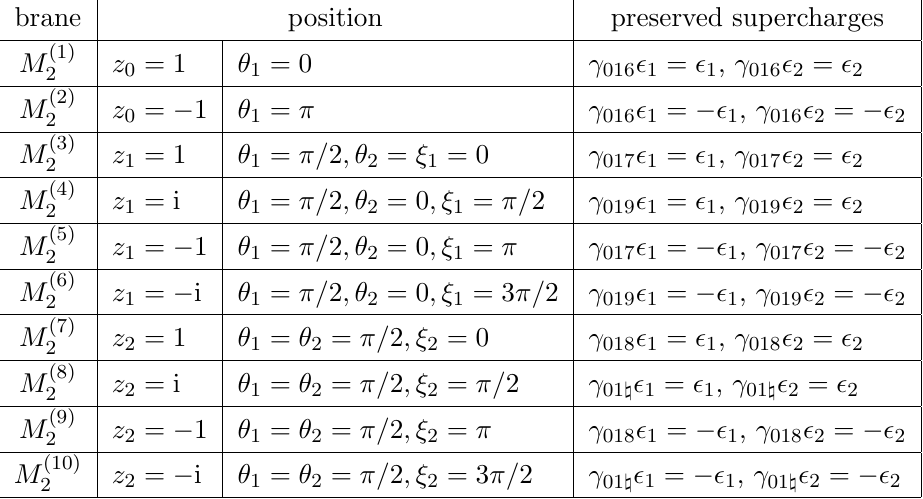
However, it is easy to realize that there are ten pairs of brane and anti-brane